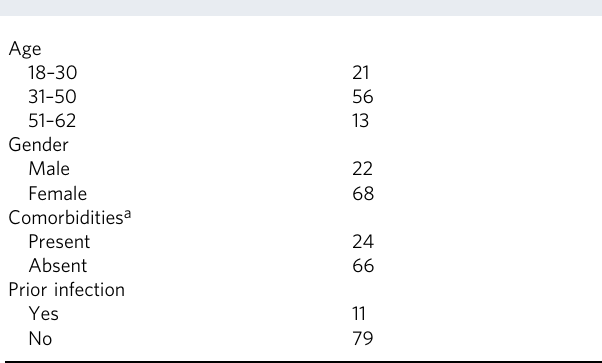
Table 1 General characteristics of the cohort included in the